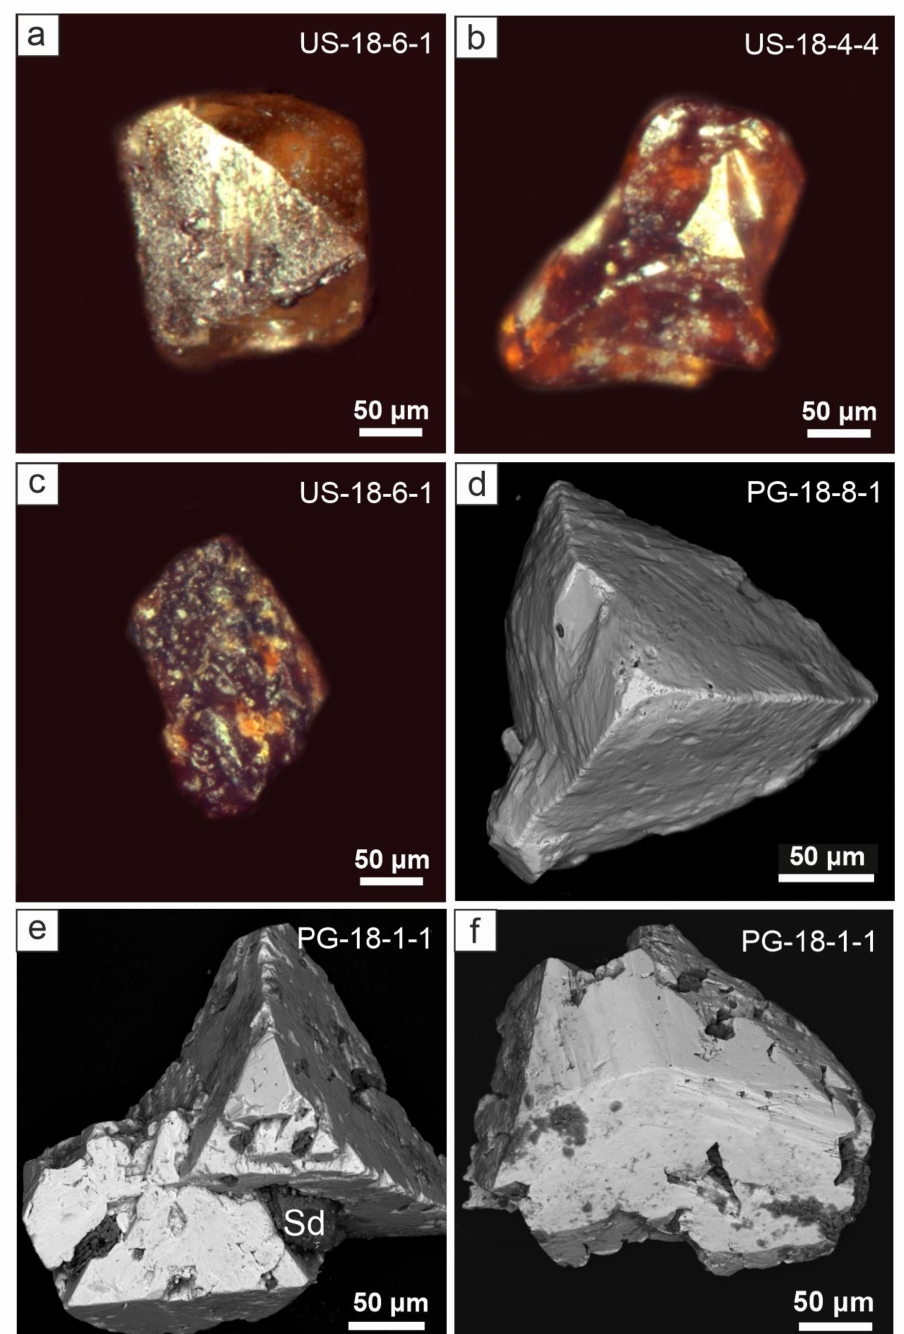
Figure 9. Appearance and morphology of low-Hg (<0.3 wt%) sphalerites from mud masses of South Sakhalin ( a – c ) and Pugachev ( d – f ) MVs. Optical images: ( a ) pseudo-octahedron, ( b ) intergrowth of tetrahedrons, ( c ) irregular fragment of heavily etched grain. BSE images: ( d ) tetrahedron with rounded and slightly etched tetrahedron surface, ( e ) intergrowths of sphalerite tetrahedrons with clay matter and siderite, ( f ) trigon-tritetrahedron. Sd =